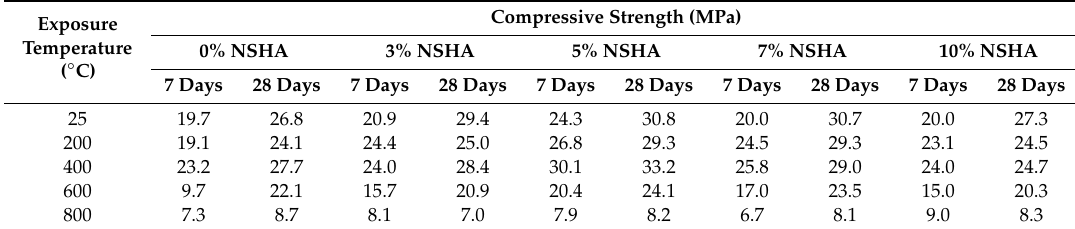
Table 5. Residual compressive strength versus temperature for the 7 and 28 days cured